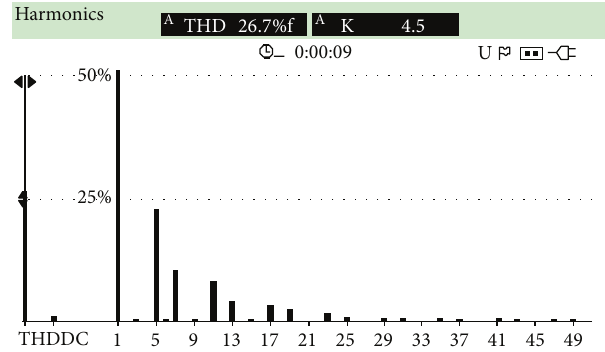
Figure 10: Phase A current spectrum before compensation.